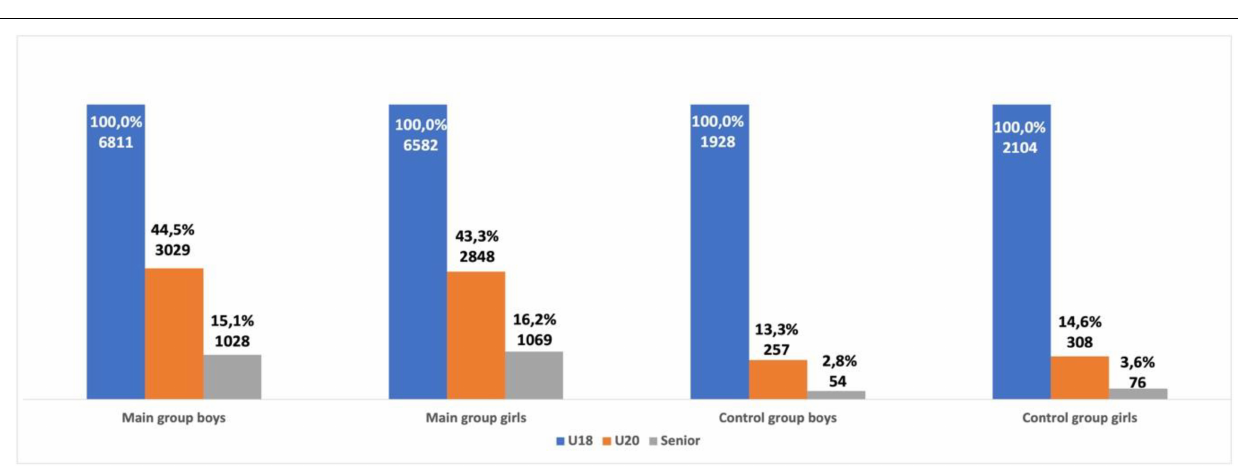
FIGURE 7 | Career trajectory of U18 male and female athletes from group one and group